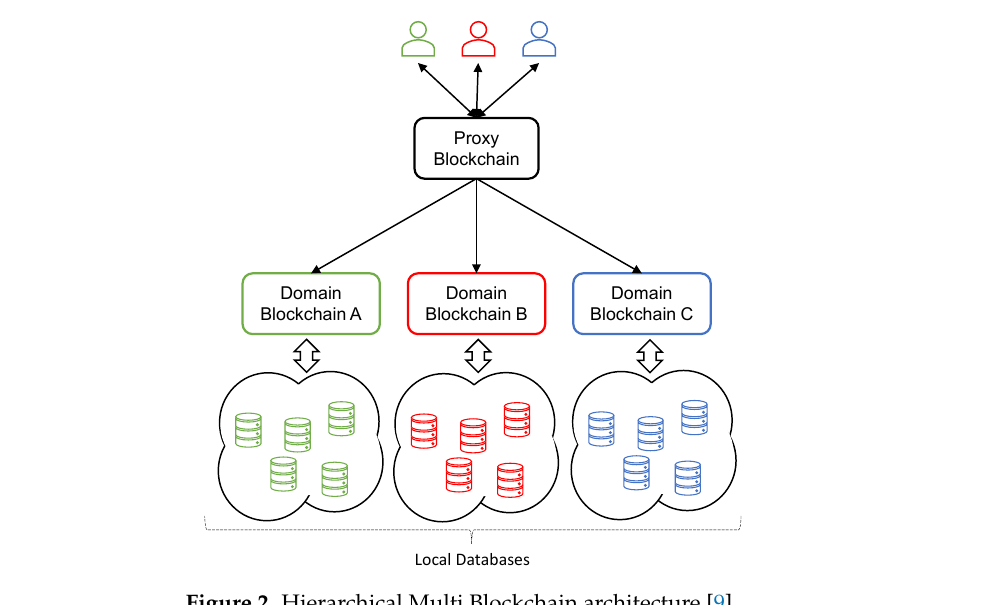
Figure 2. Hierarchical Multi Blockchain architecture